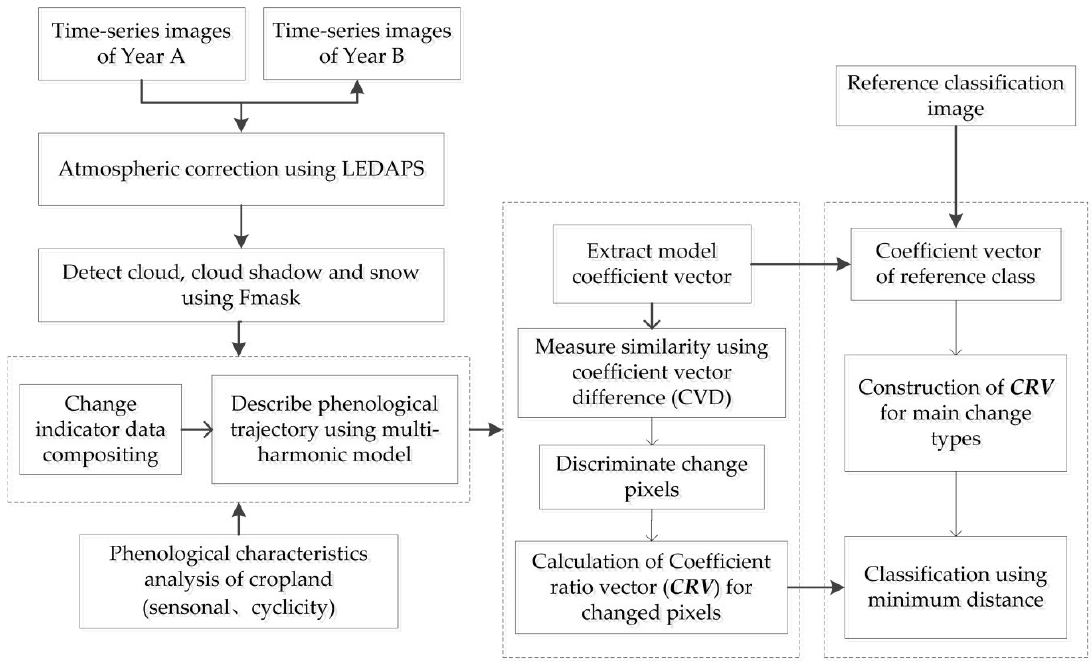
Figure 1. Outline of the overall methods adopted in this study .